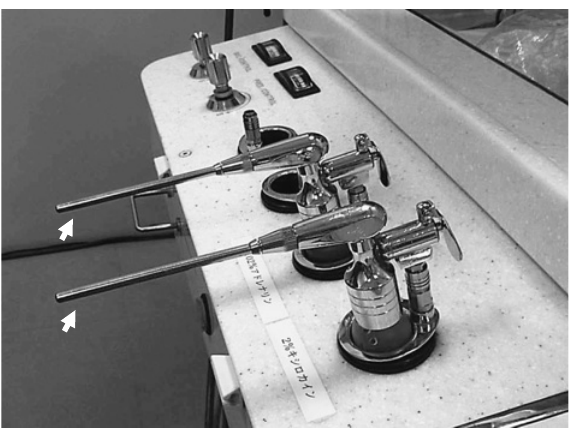
F i g . 2 Nasal spra y nozzles attached to ENT treatment u nit (ar- ro w s :